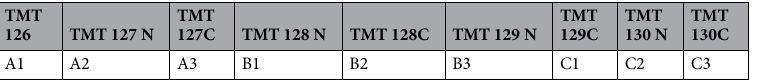
Table 4. Peptide labeling information